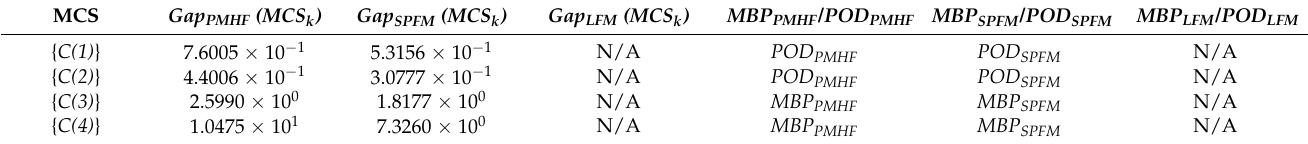
Table 4. List of MCSs and their quantified gaps to the target values and MBP/POD